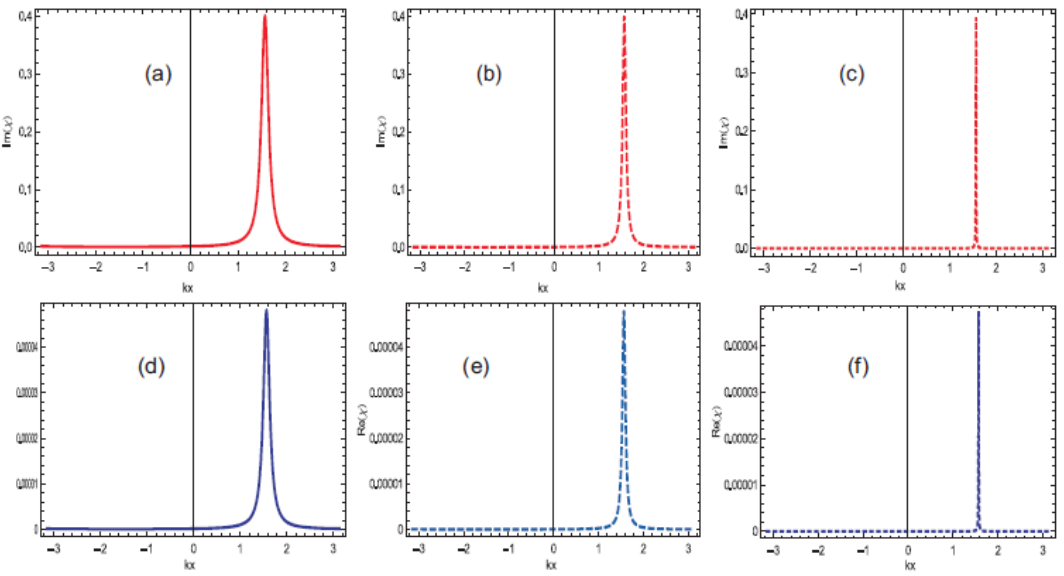
Figure 2. Localization of atom vs kx at the parameters γ = 1 GHz , | Ω 1,2,3 | = R = 50 γ [ a , d ] ,100 γ [ b , e ] ,1000 γ [ c , f ] ,